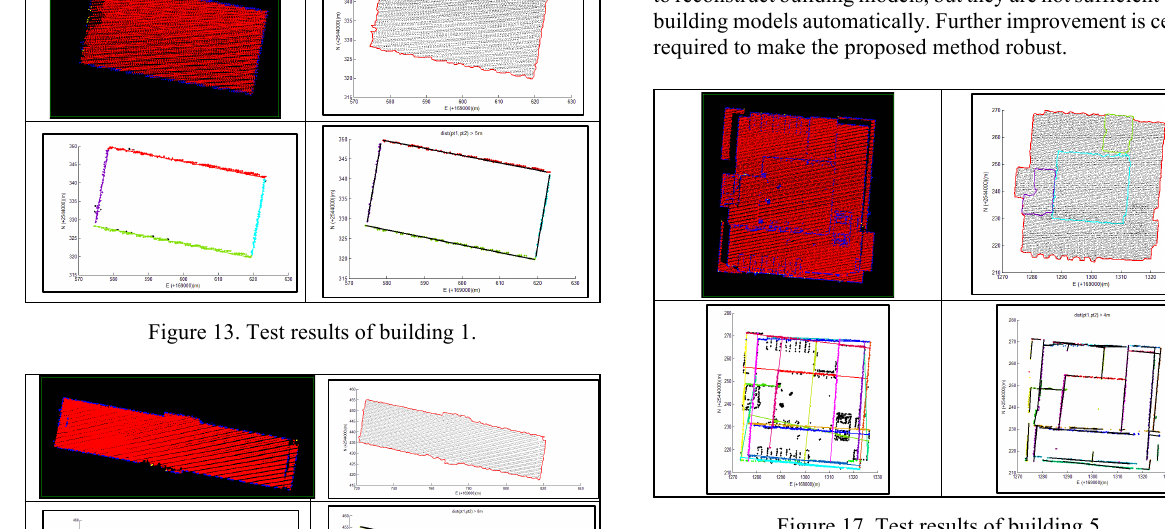
Figure 17. Test results of building 5.